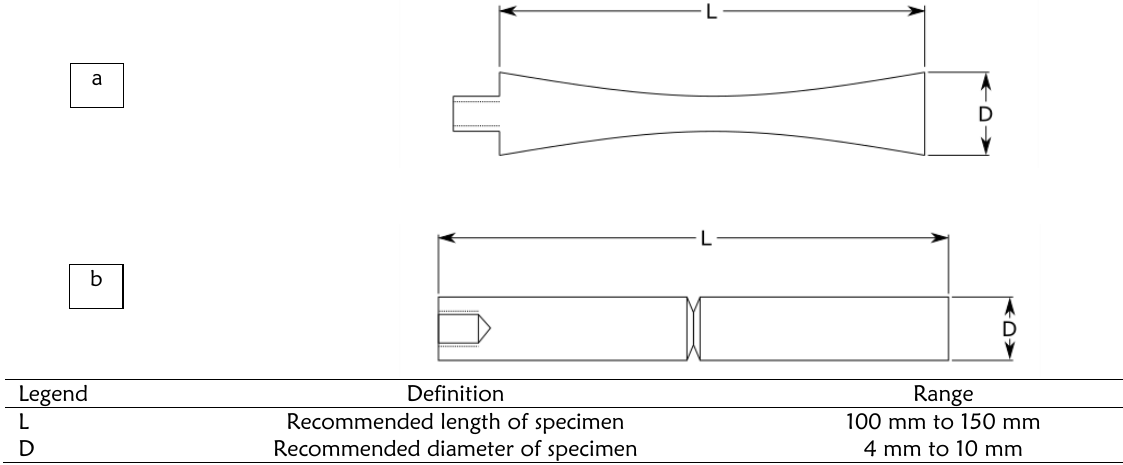
Figure 9: Geometries used for ultrasonic fatigue testing, (a) smooth specimen and (b) notched specimen